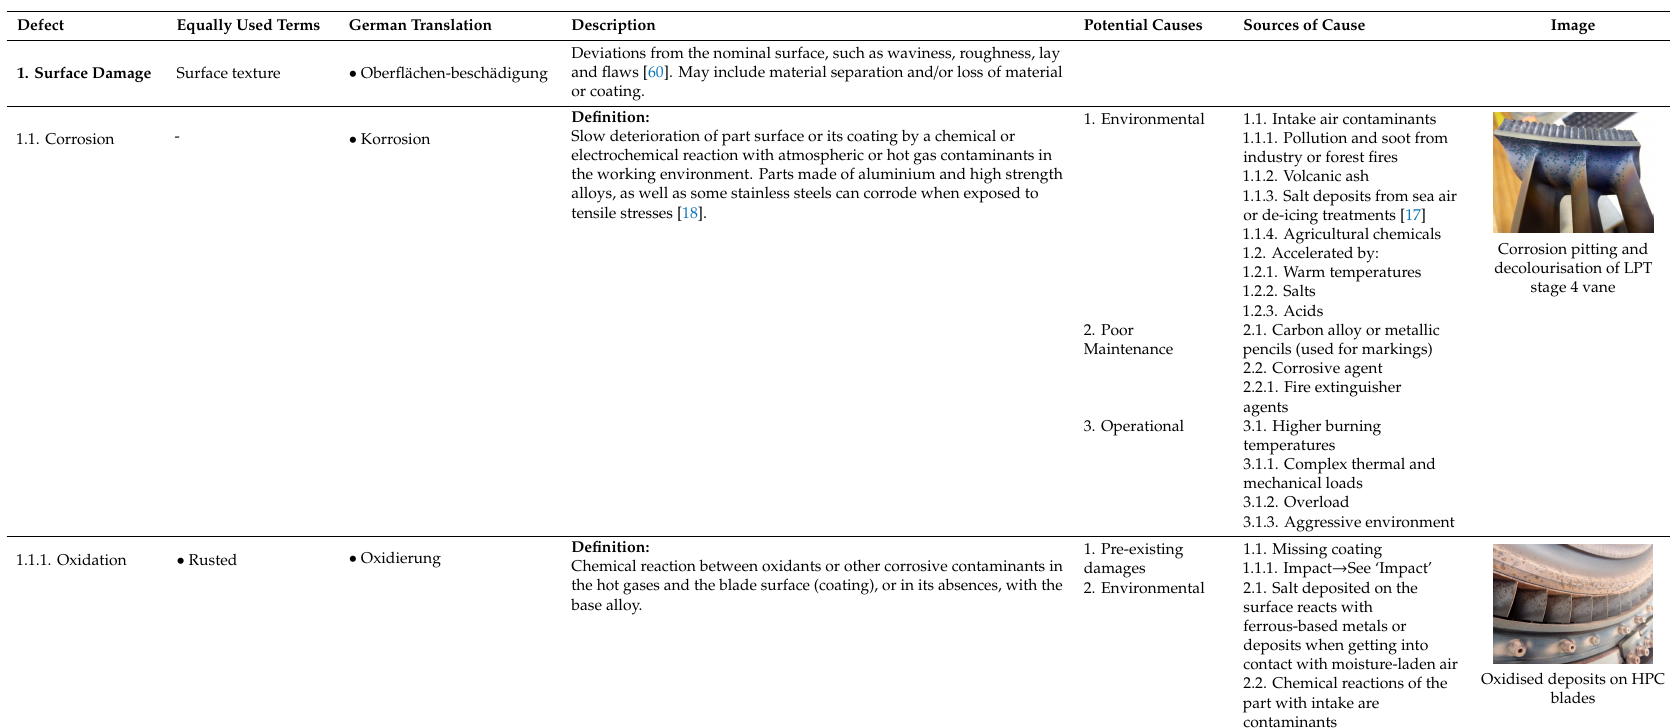
Table A1. Full root-cause and defect